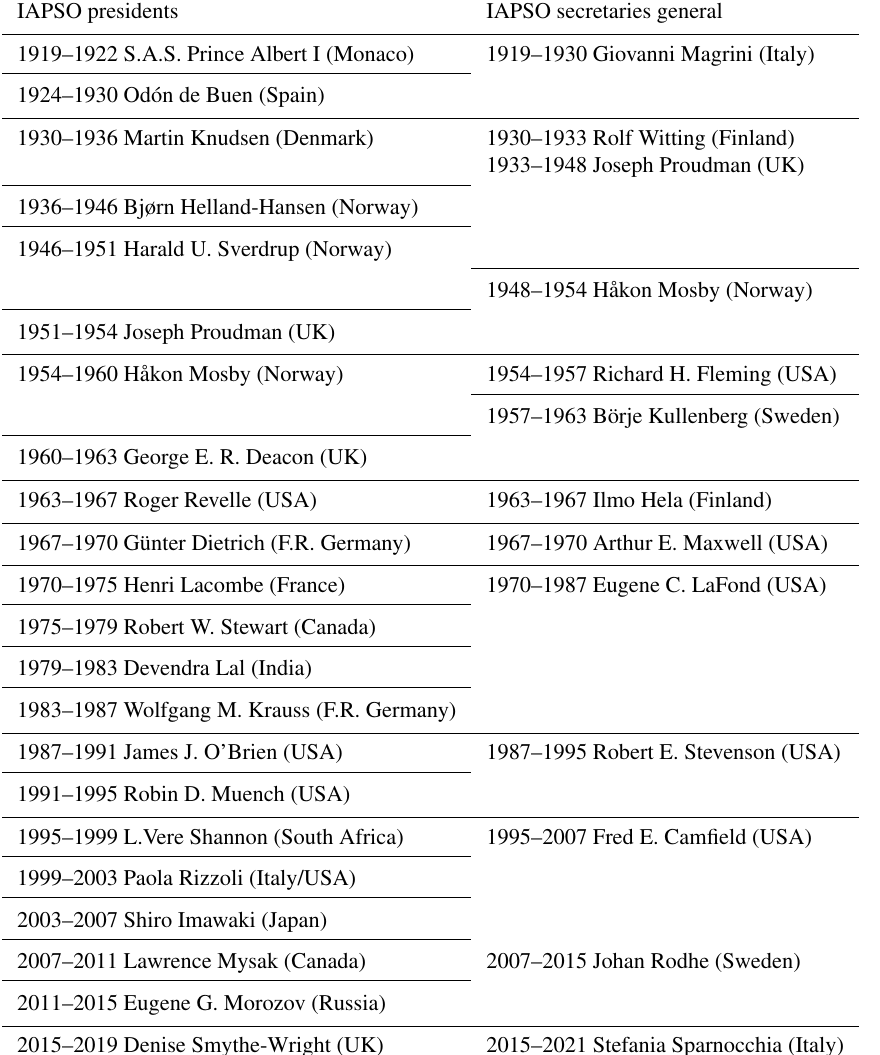
Table 1. IAPSO presidents, secretaries, and secretaries